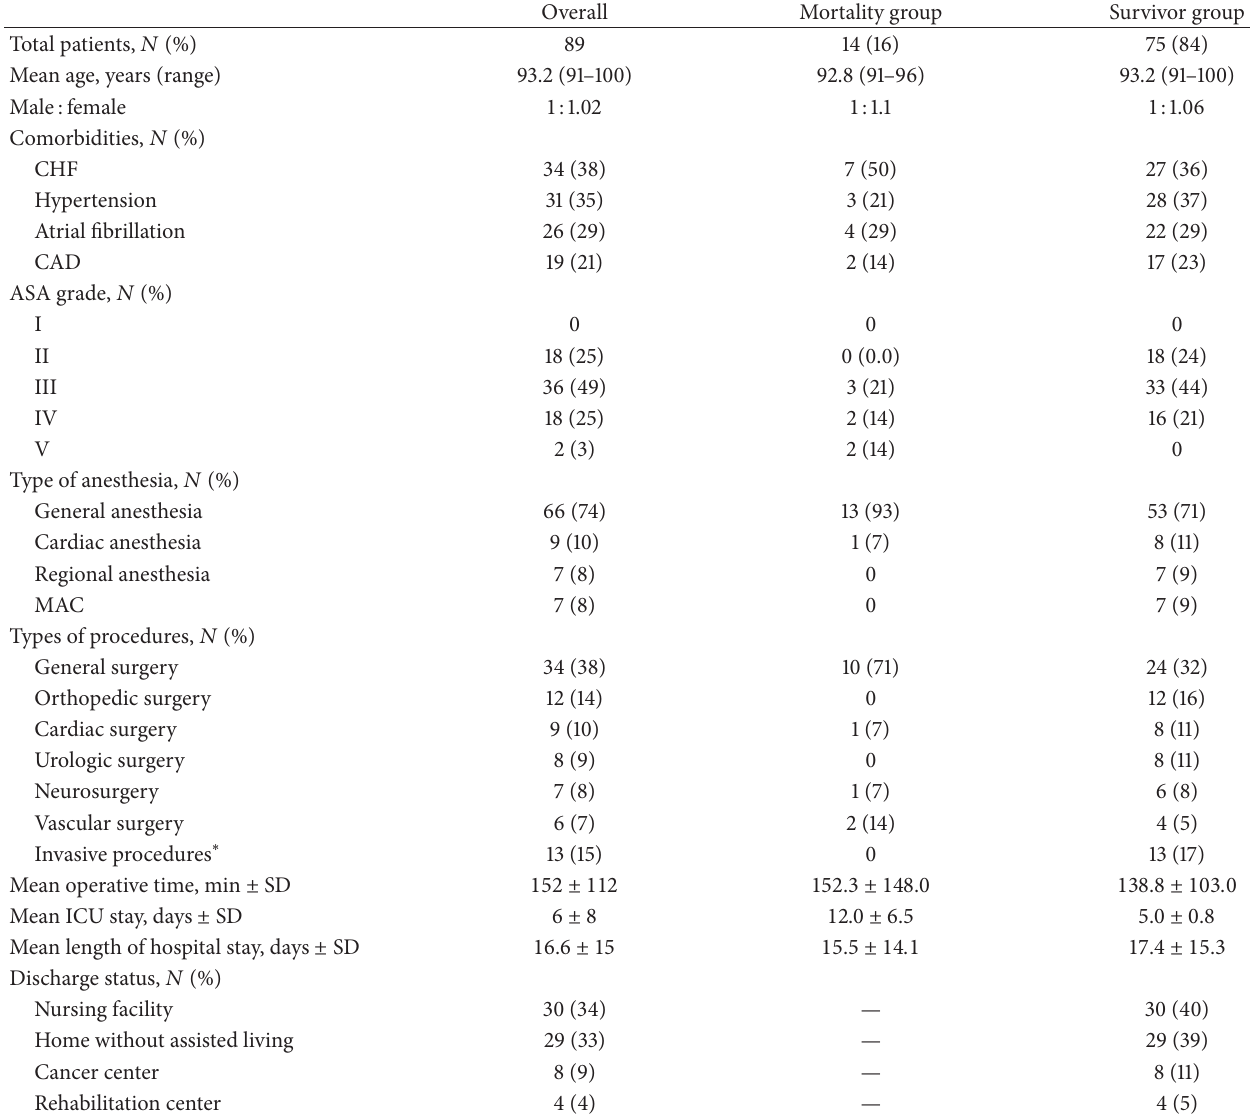
Table 2: Demographics and clinical characteristics for 89 nonagenarians admitted to the surgical ICU between 2000 and 2010.